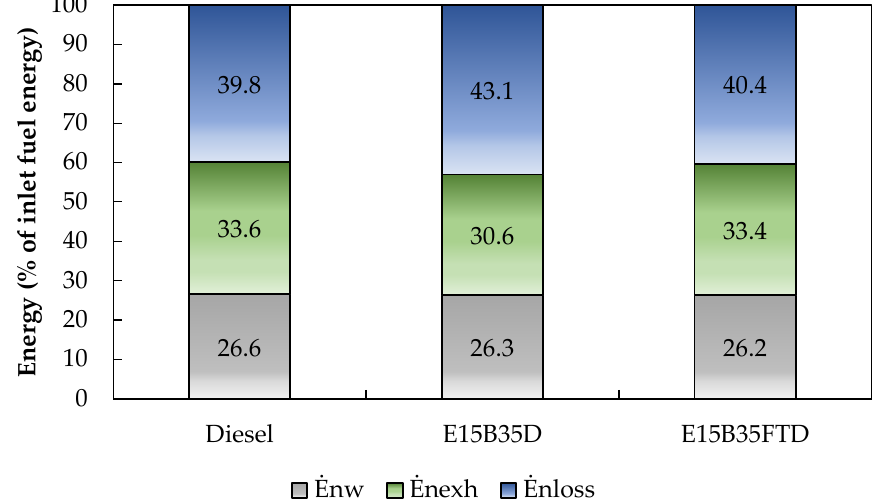
Figure 5. Energy balance of the engine for each tested fuel.